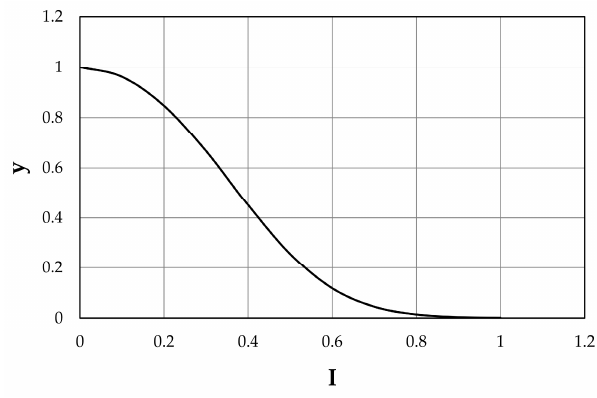
Figure 5. Physical integrity for both indices.